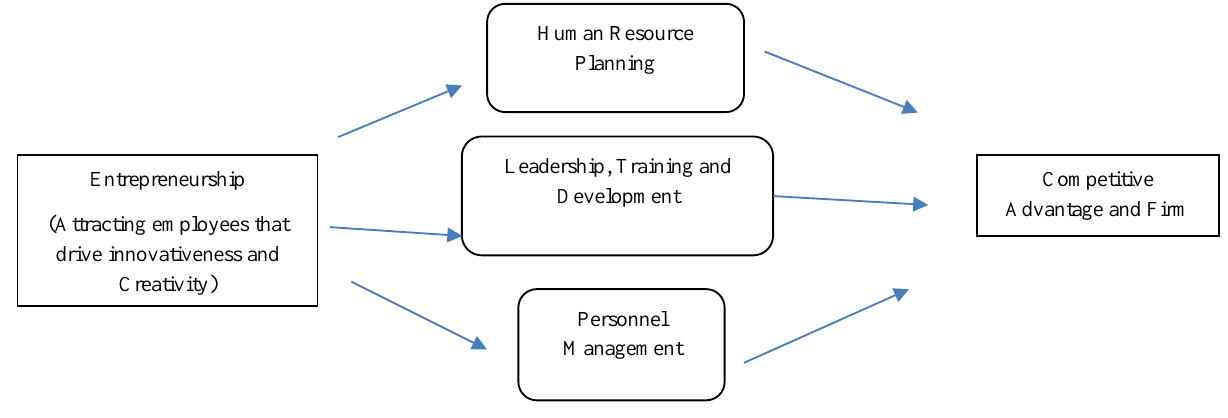
Fig.1: Conceptualizing entrepreneurship in human resource management; Source: Researchers’ Compilation, (2020) Managers attract and select employees who drive innovativeness and creativity to enhance firm competitiveness and